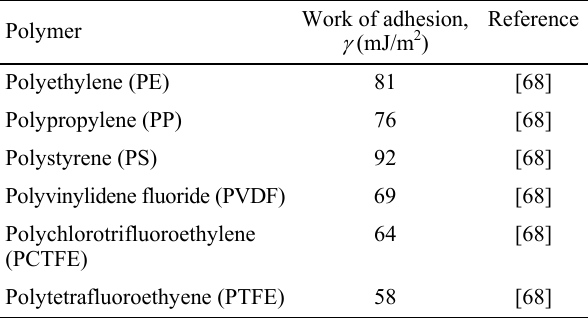
Table 3 Work of adhesion for polymers measured by AFM.